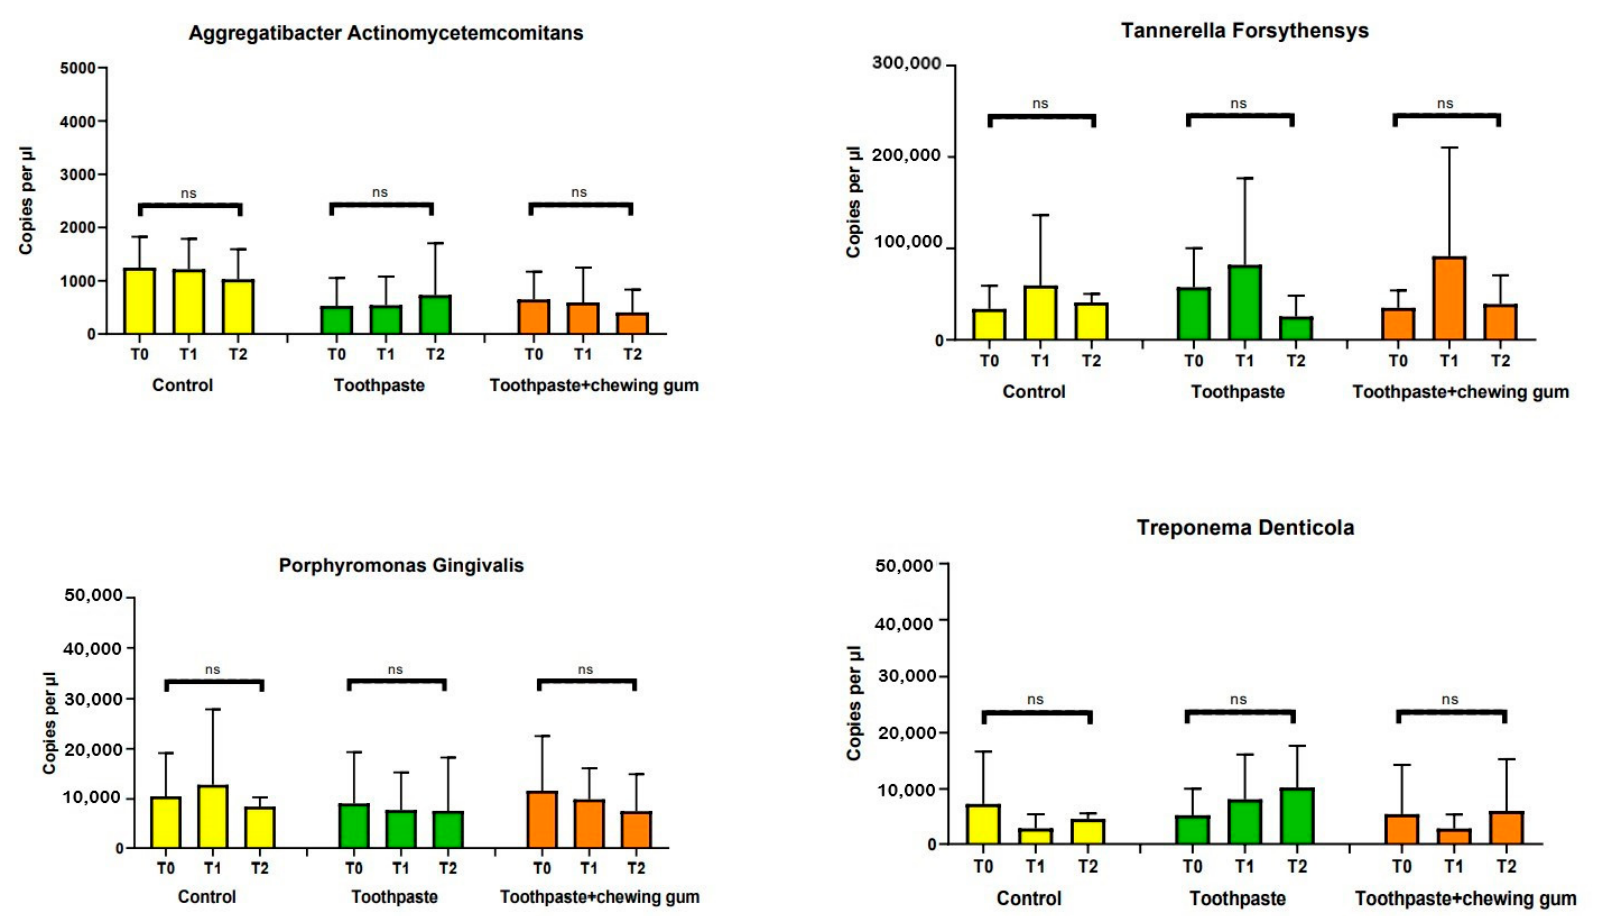
Figure 5. Pathogen Bacteria (%); Enlarged Red Complex (%); Red Complex (%); Total Bacteria Count (copies/µL); Aggregatibacter actinomycetemcomitans (copies/µL); Tannerella forsythia (copies/µL); Porphyromonas gingivalis (copies/µL); Troponema denticola (copies/µL). ns: not significant difference ( p > 0.05).